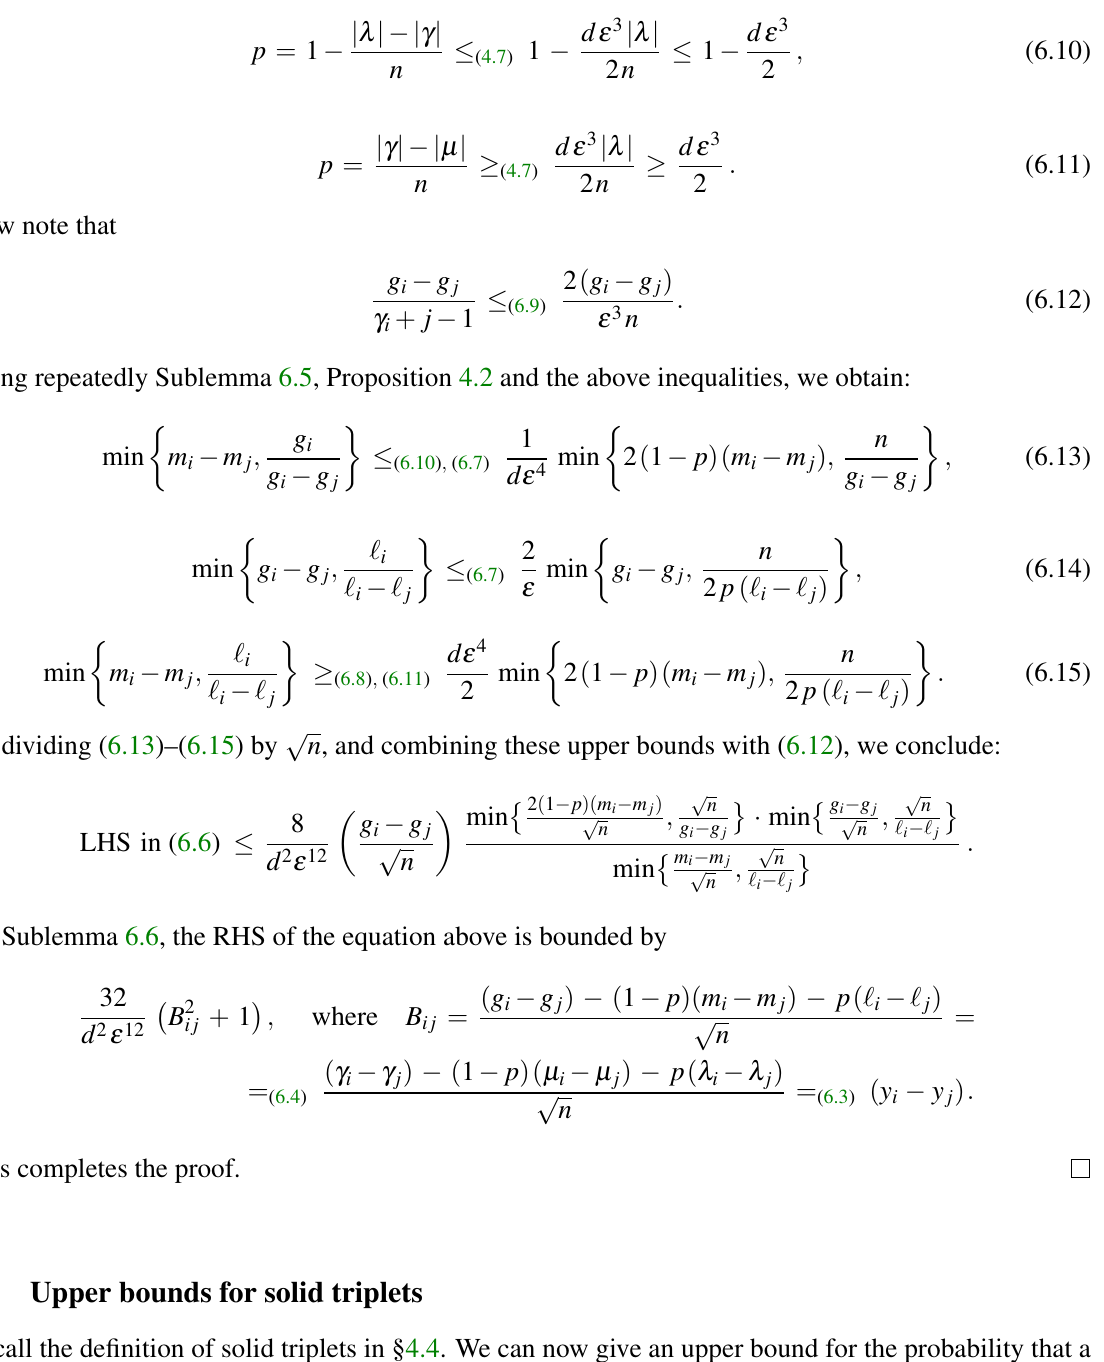
D ISCRETE A NALYSIS , 2021:24,